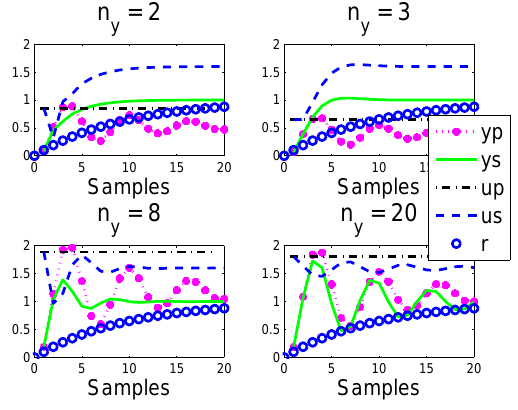
Figure 15. Closed-loop PFC input and output us; ys responses overlaid with predictions up; yp made at the first sample for an oscillatory system G